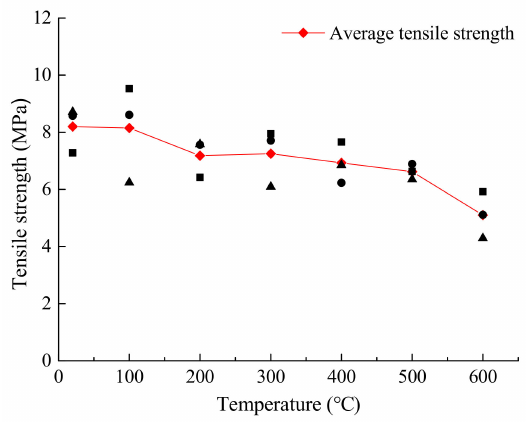
Figure 6. Tensile strength at different temperatures.